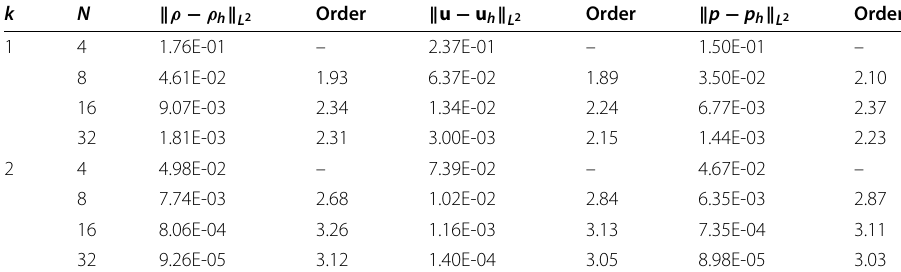
Table 4 Accuracy test for adaptive IMEX-RK-LDG scheme of 3D NS equations k